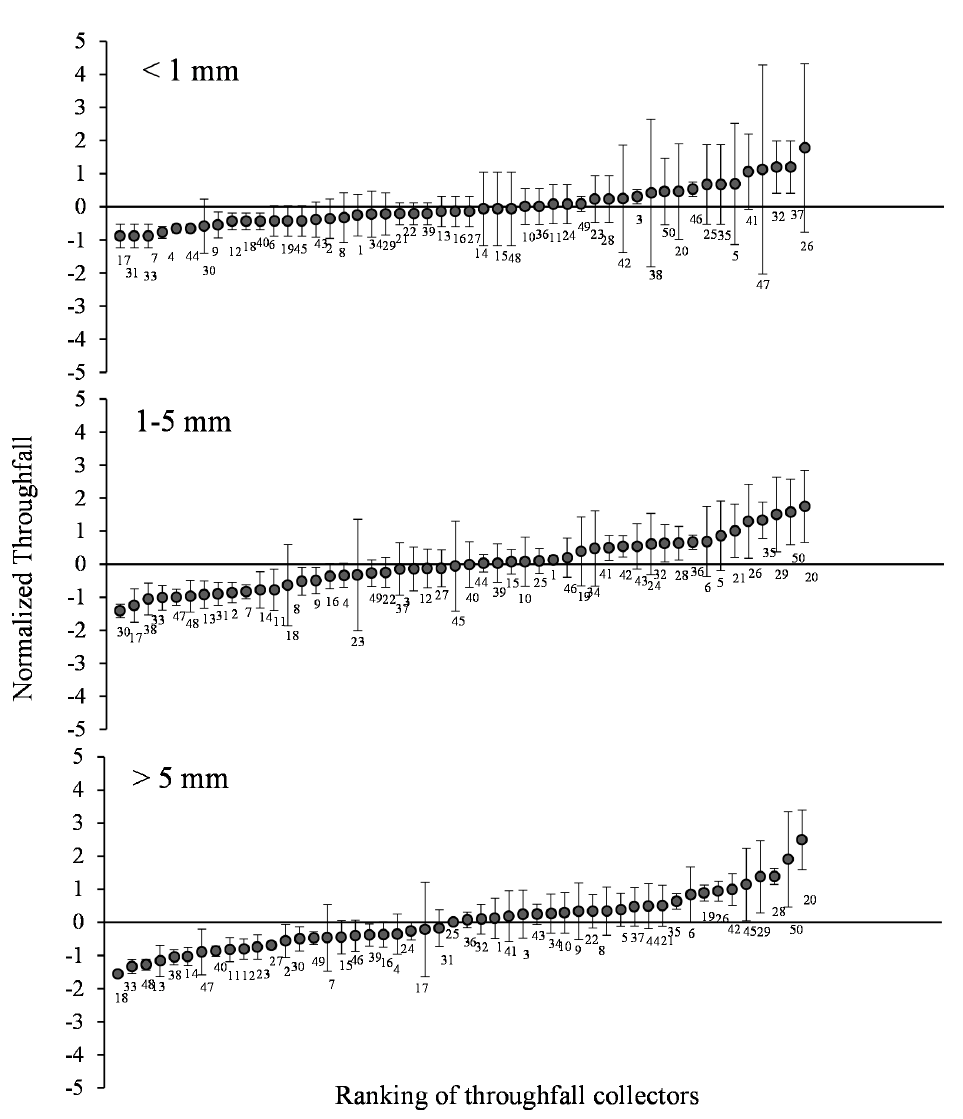
Figure 8. Time stability plots for throughfall ( TF ). Time-average relative deviation of TF amount by collectors for events grouped within three rainfall classes during the study period. Error bars are plus and minus one standard deviation; numbers refer to collector number ( n = 50).